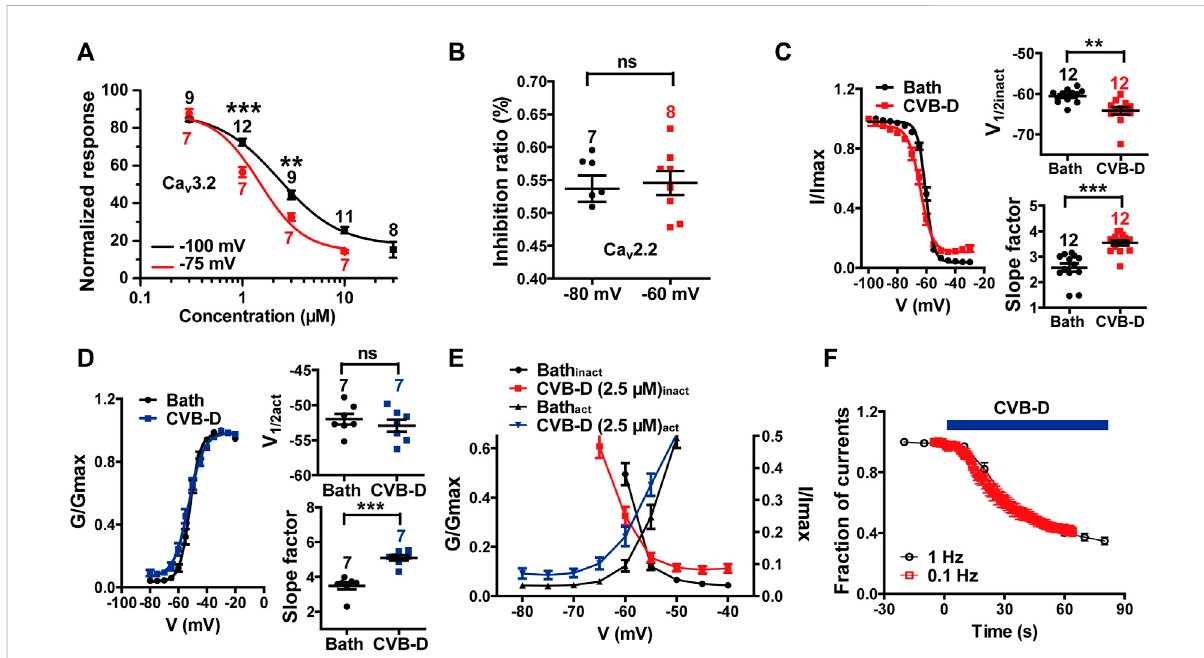
FIGURE 4 EffectofCVB-DonelectrophysiologicalpropertiesofrecombinantCa v 3.2andCa v 2.2channelsexpressedinHEK293Tcells. (A) Dose-response relationship of CVB-D inhibition of Ca v 3.2 peak current from a HP at − 100 mV (black) or − 75 mV (red), respectively. Solid curve represents fi t to the Hill equation. (B) Inhibition by 2.5 μ M CVB-D of Ca v 2.2 at a HP of − 80 mV or -60 mV, respectively. (C) Effect of CVB-D (2.5 μ M) on Ca v 3.2 inactivation. Left panel is the inactivation curve of Ca v 3.2 in the presence (red) or absence of CVB-D (black). Solid curve represents fi t to the Boltzmann equation. Right upper panel is the comparison of the half-inactivation potential (V 1/2 ) in the presence (red) or absence of CVB-D (black). Right lower panel is the comparison of the slope factor in the presence (red) or absence of CVB-D (black). (D) Effect of CVB-D (2.5 μ M) on Ca v 3.2 activation. Left panel is the activation curve of Ca v 3.2 in the presence (blue) or absence of CVB-D (black). Solid curve represents fi t to the Boltzmann equation. Right upper panel is the comparison of the half-activation potential (V 1/2 ) in the presence (blue) or absence of CVB-D (black). Right lower panel is the comparison of the slope factor in the presence (blue) or absence of CVB-D (black). (E) Comparison of Ca v 3.2 window currentsinthepresence(redforinactivationcurve,blueforactivationcurve)orabsenceofCVB-D(black). (F) EffectofCVB-DonCa v 3.2stimulatedat afrequencyof0.1or1 Hz.Datainformation:Thenumberineachgraphindicatedthenumberofcellsusedineachexperiment.Statisticalsigni fi cance was evaluated using two-tailed t -test (for two-group comparisons), with * p < 0.05, ** p < 0.01, and *** p < 0.001; ns indicates no signi fi cance. The exact t, F, and p -values are indicated in Appendix Table S1. All the data are presented as mean ±